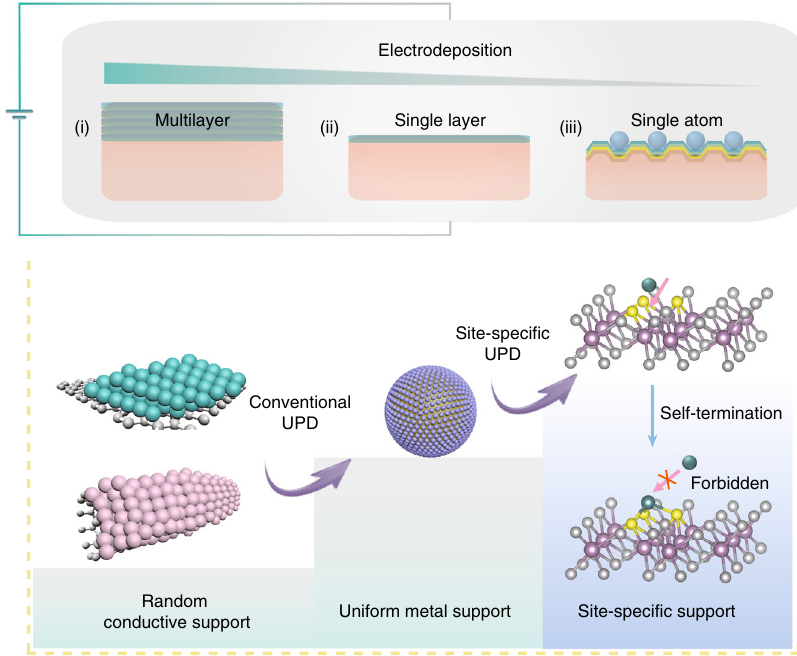
Fig. 1 Methodological development of ADMC preparation by electrodeposition. The blue wedge structure represents the downsizing of electrodeposition on nanomaterials from a multilayer (i) to a single layer (ii) and further to single atoms (iii). Representative examples of each electrochemical method are shown: (i) Electrically conductive substrates with high surface areas (e.g., graphene or carbon nanotubes) are often used to electrodeposit metal nanoparticles or metallic thin fi lms. However, this process typically leads to the formation of a multilayered bulk phase (represented by the blue or pink ball constructed nanostructures in the fi gure). (ii) Conventional underpotential deposition (UPD), typically of a metal cation (e.g., Cu 2 + , Ag + , Bi 3 + , or Pb 2 + ) deposited onto uniform metal support (e.g., Au, Pd, or Pt) at a potential more positive than its equilibrium potential (the potential at which it deposits onto itself), has been widely investigated for the growth of a 2D single layer. (iii) Inspired by these fi ndings, we proposed that the synthesis of ADMCs might be realized through site-speci fi c electrodeposition on transition metal dichalcogenides (e.g., MoS 2 ) with isolated active sites for UPD. The site-speci fi c UPD enables the energetically favorable deposition of single-atom metal on the chalcogen sites, and then automatically terminates the sequential aggregation of metal